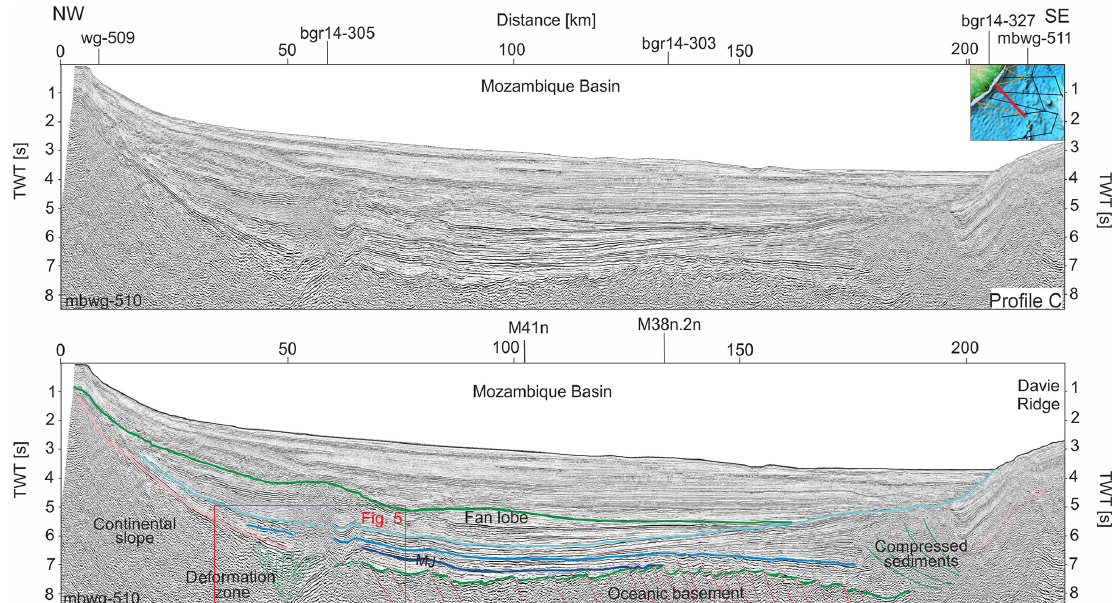
Figure 4. Migrated section of profile Mbwg00-510 (line location in inset map and Fig. 1). The lower panel shows the section overlain by the stratigraphic interpretation according to Castelino et al. (2015), Franke et al. (2015) and Mahanjane (2014). The profile runs from the continental slope to the Davie Ridge offshore of Madagascar. The zone of deformed basement is observed at the foot of the continental slope. The Davie Ridge appears as bathymetric high, rising 1s (TWT) above the surrounding seafloor. At the foot of the western flank of Davie Ridge, a zone of deeply buried, compressed sediments is observed that might have been thrusted onto the oceanic crust during southward motion of